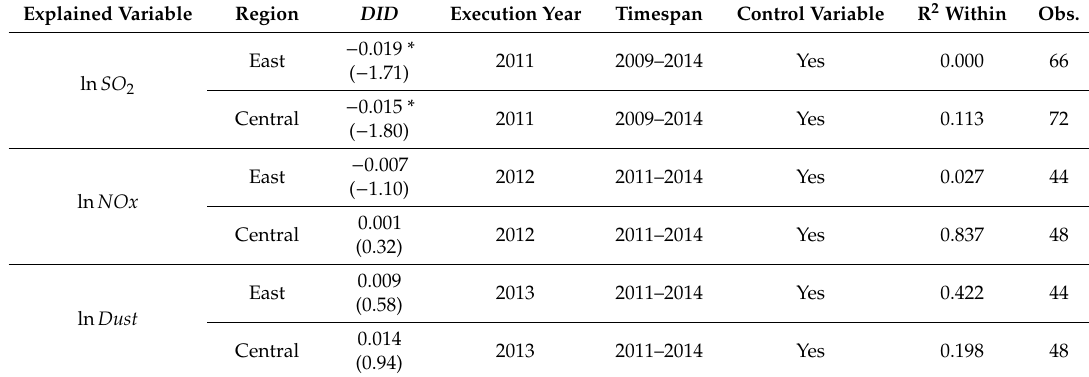
Table 7. Placebo test